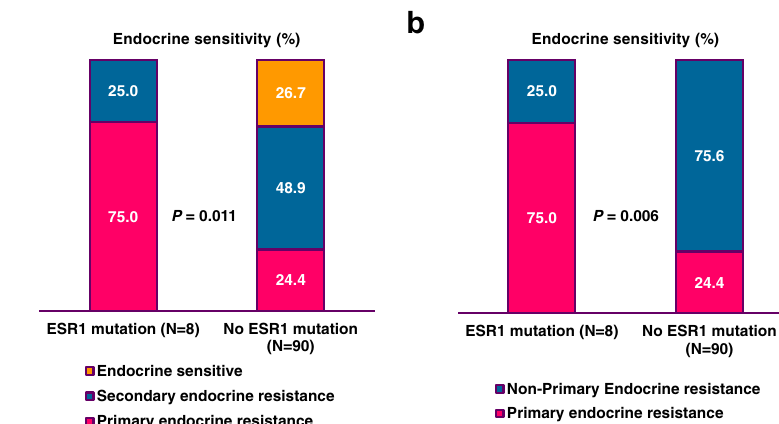
Fig. 5 The relationship between ESR1 mutation and recurrence type according to responsiveness to adjuvant endocrine therapy. a Primary endocrine resistance, secondary endocrine resistance, and endocrine sensitivity ( p = 0.011; chi-square test) b Primary endocrine resistance versus non-primary endocrine resistance ( p = 0.006; Fisher ’ s exact test). Table 2. Univariate and multivariate analysis of primary endocrine resistance in patients who received endocrine therapy. Univariable